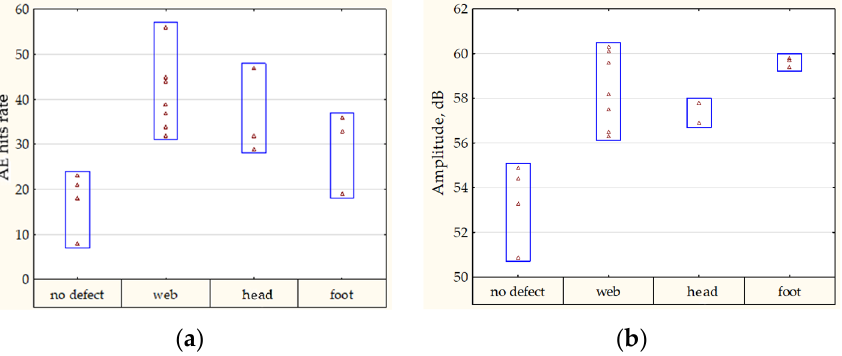
Figure 11. Variability plots for AE hit rate ( a ) and quantile q 0.9 of amplitude distribution ( b ) for specimens with different crack locations.